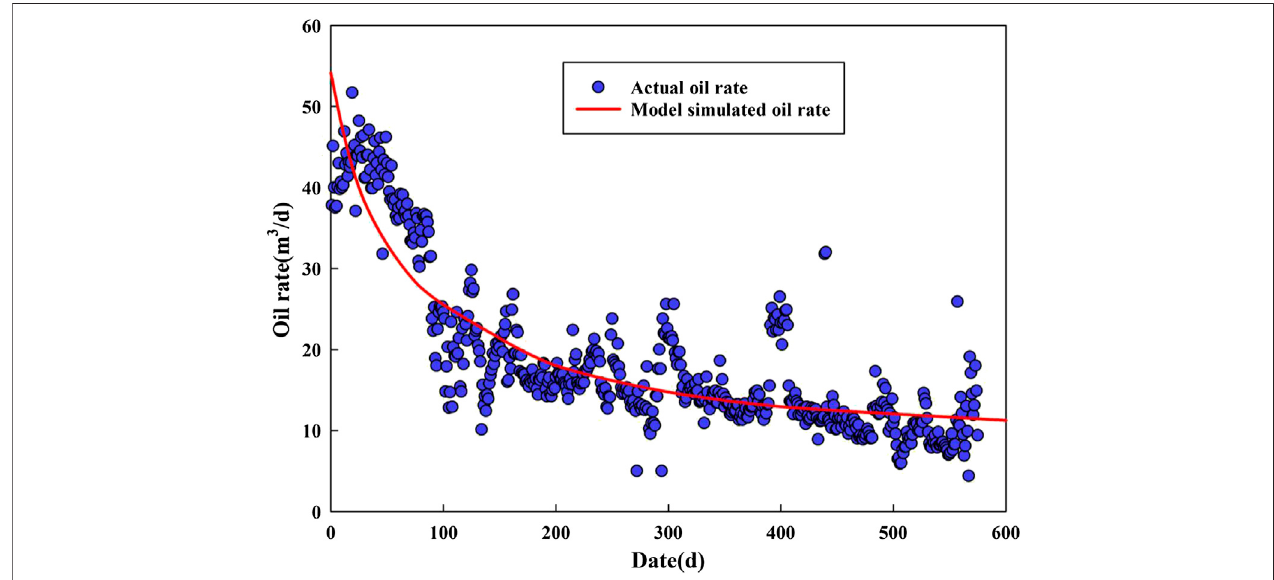
FIGURE 3 | Comparison between actual production and model production.